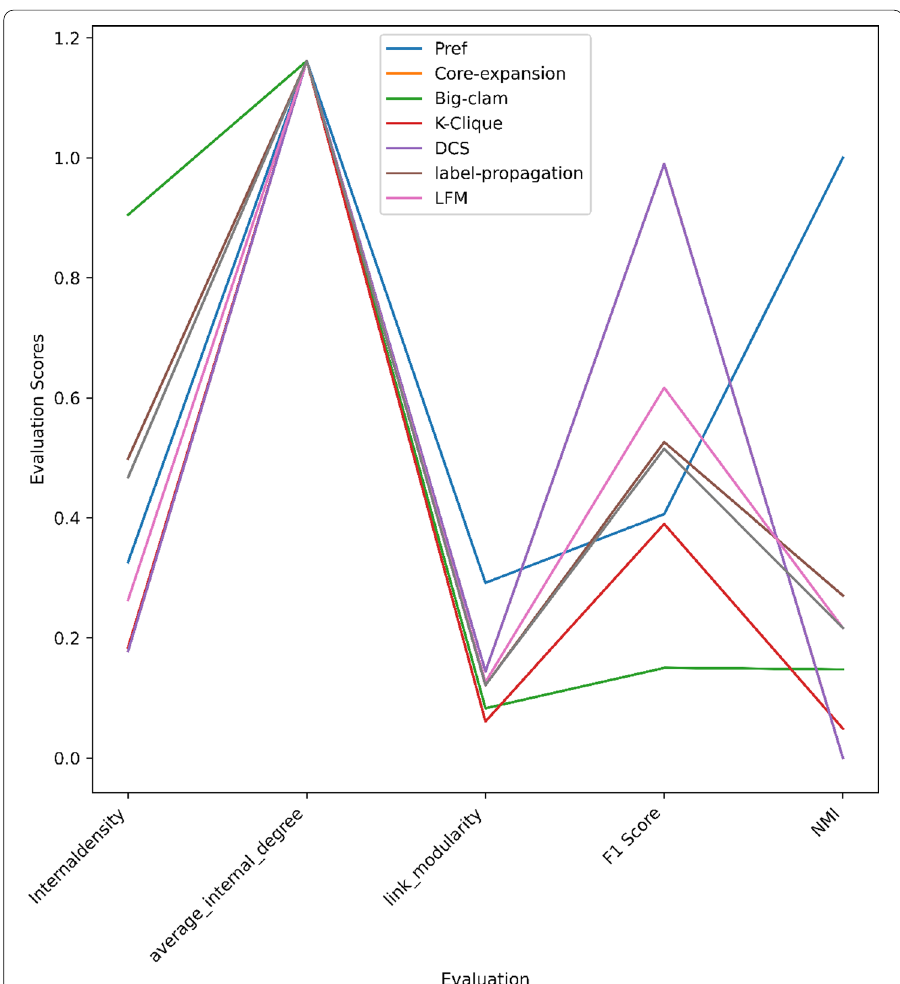
Fig. 13 Different measures such as internal degree, link modularity, F1 score, NMI are plotted for Zachary karate club using community detection algorithms. We have used Core-expansion, Big-clam, K-clique, DCS, label-propagation and LFM to show further